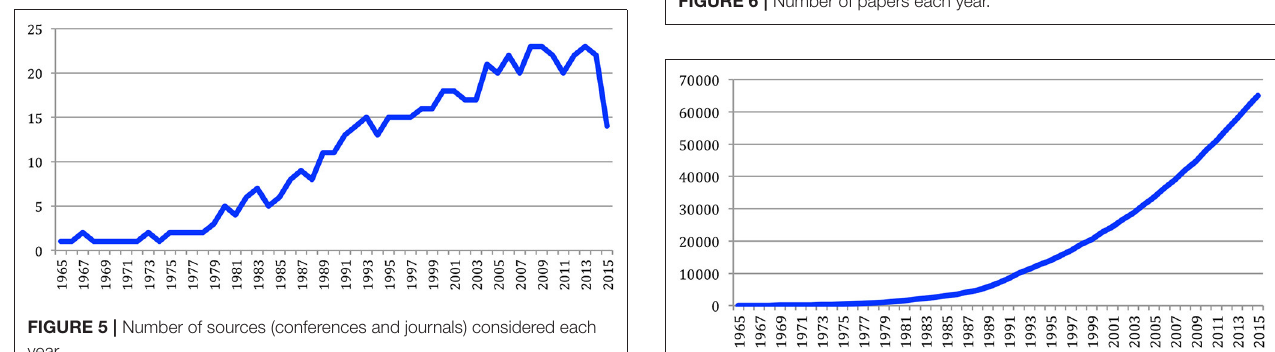
FIGURE 6 | Number of papers each year.